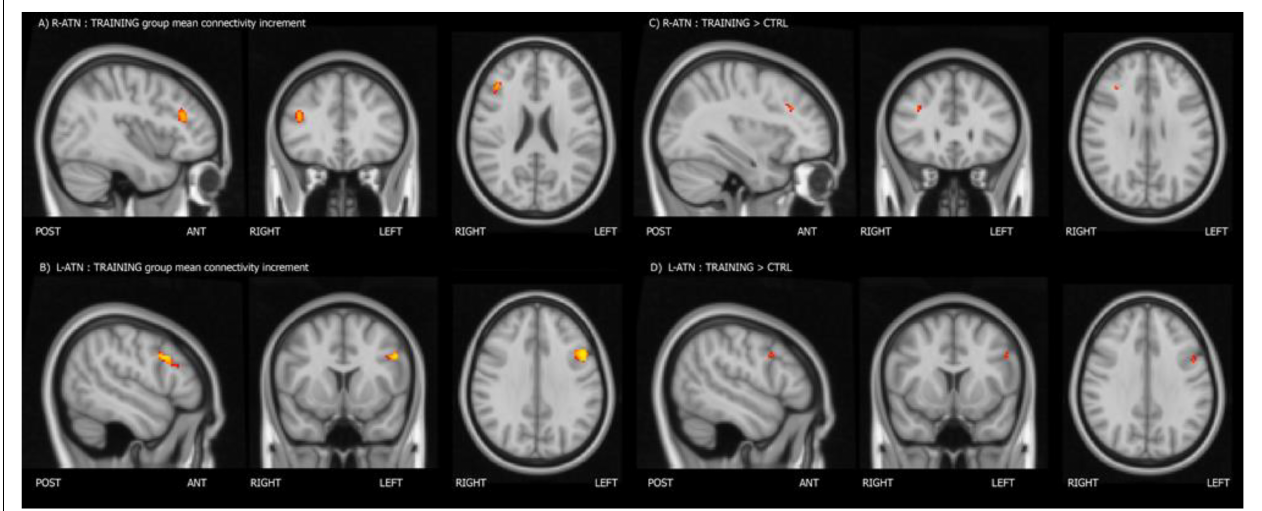
FIGURE 2 | Mean connectivity increment within the training group (A,B) , and group-within-network (GWN) connectivity increment in the training group with respect to the control group (C,D) .